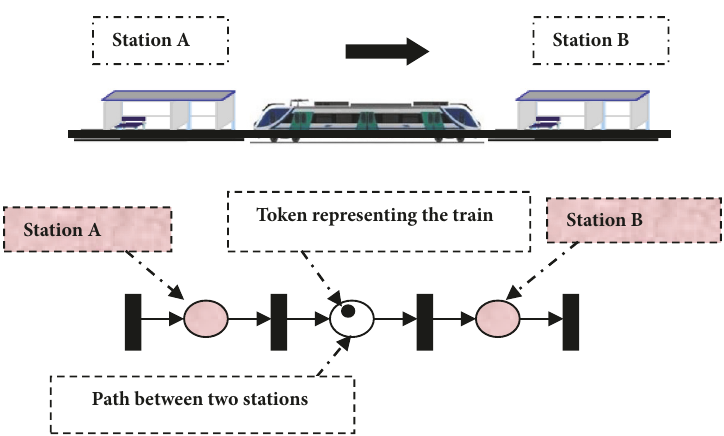
Figure 3: Single directional segment model.